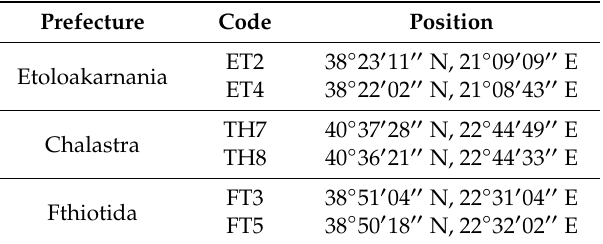
Table 1. Prefecture, code and geographical position of E. colona accessions included in the present study. Single accessions were collected from each